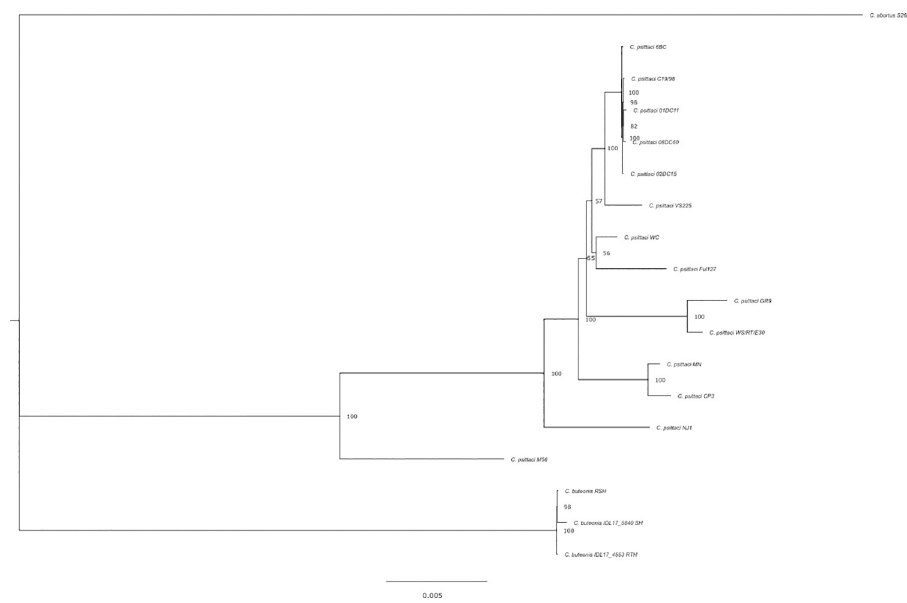
Fig 1. Maximum likelihood phylogenetic tree showing that the SWHA and RTHA isolates were most similar to C . buteonis . The tree was computed using programs IQtree [33]+ ModelFinder [34] with 1000 iterations of bootstrapping from a pan-genomic analysis using Anvi’o [35] based on aligned protein sequences from all shared sing copy gene